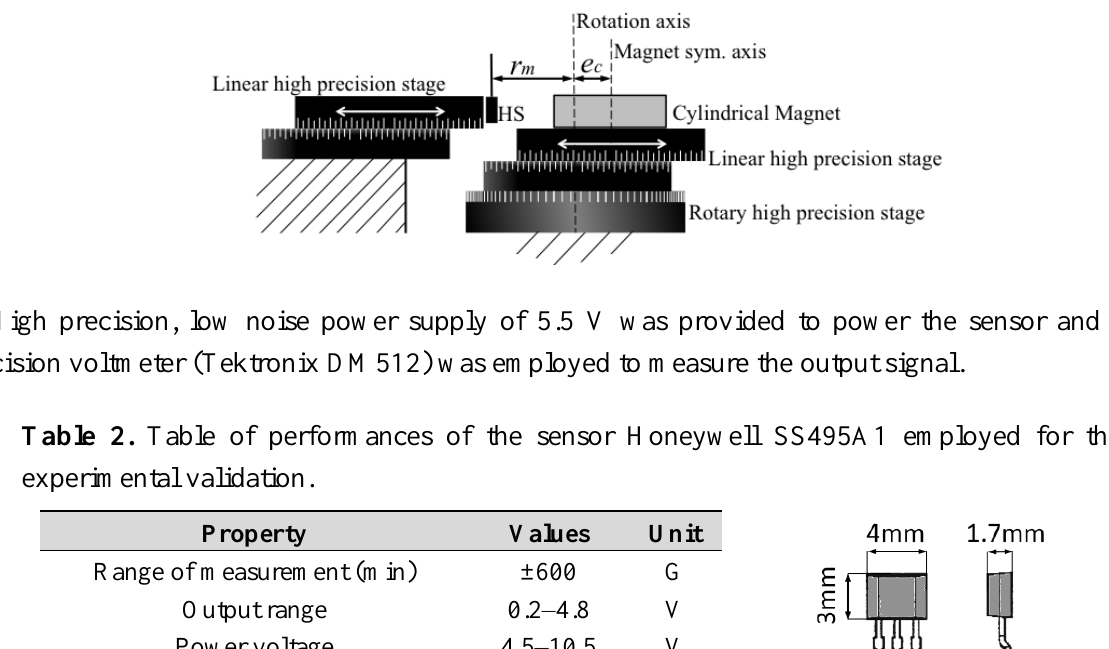
Figure 8. Scheme of the experimental setup employed for the validation of the model and the optimization procedure.